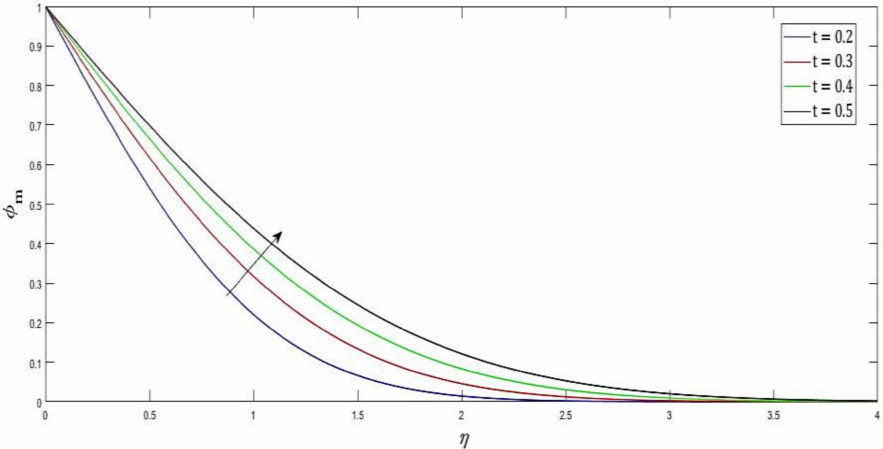
Figure 10. Variation in concentration profile with respect to